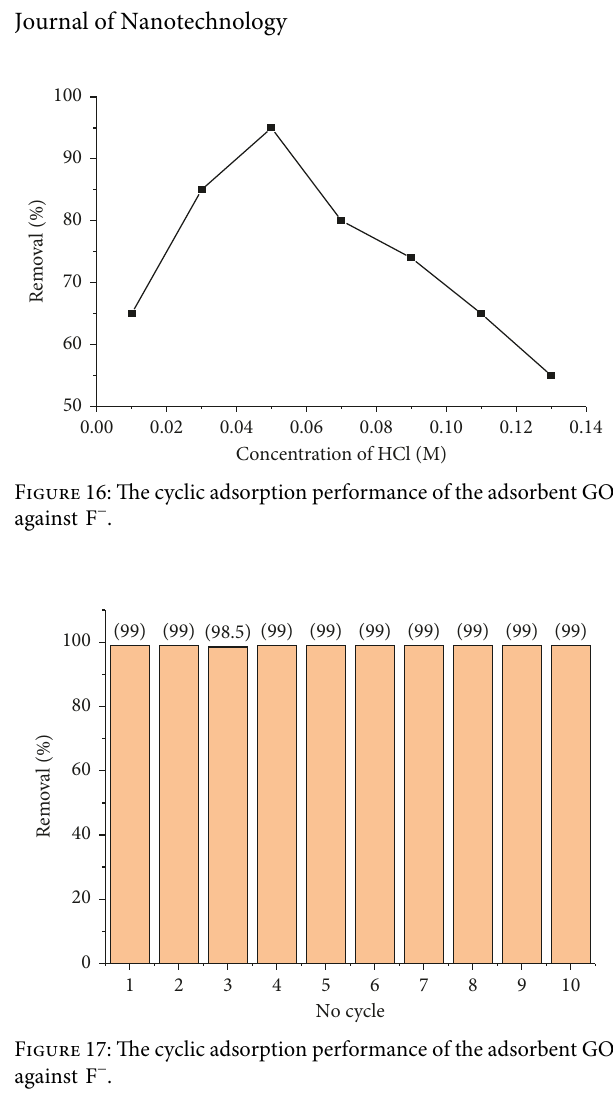
Figure 17. The pH adjustment was done by HCl/H NaOH and the maximum adsorption capacity of GO was recovered and recorded to be 99%.